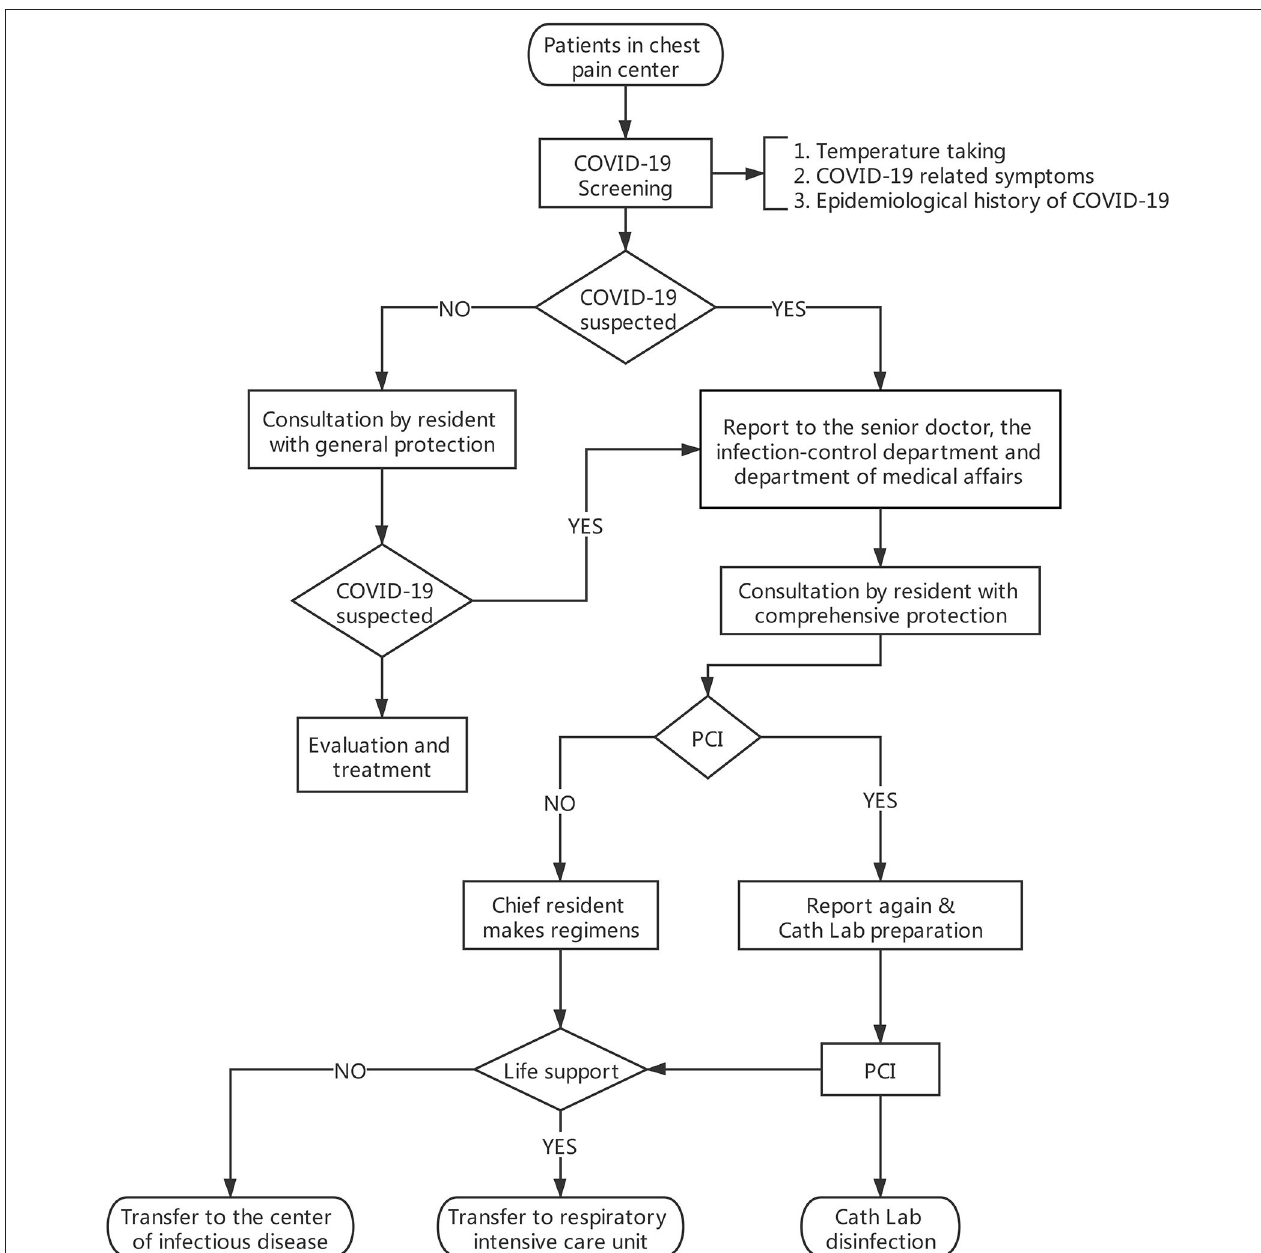
FIGURE 1 | PCI workflow and patient triage process. General protection: medical uniforms, surgical mask, medical cap, and rubber gloves. Comprehensive protection: gown, medical N95 mask, goggles, medical cap, and rubber